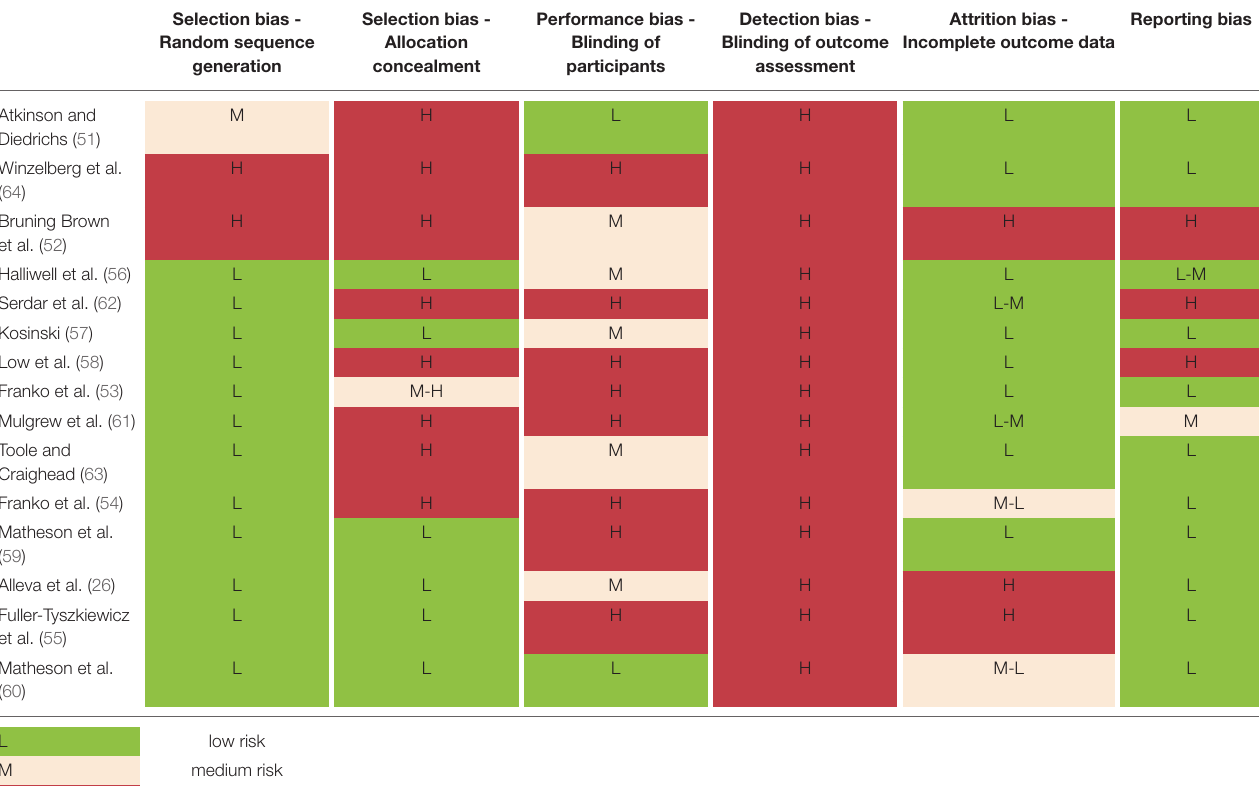
TABLE 2 | Cochrane quality assessment